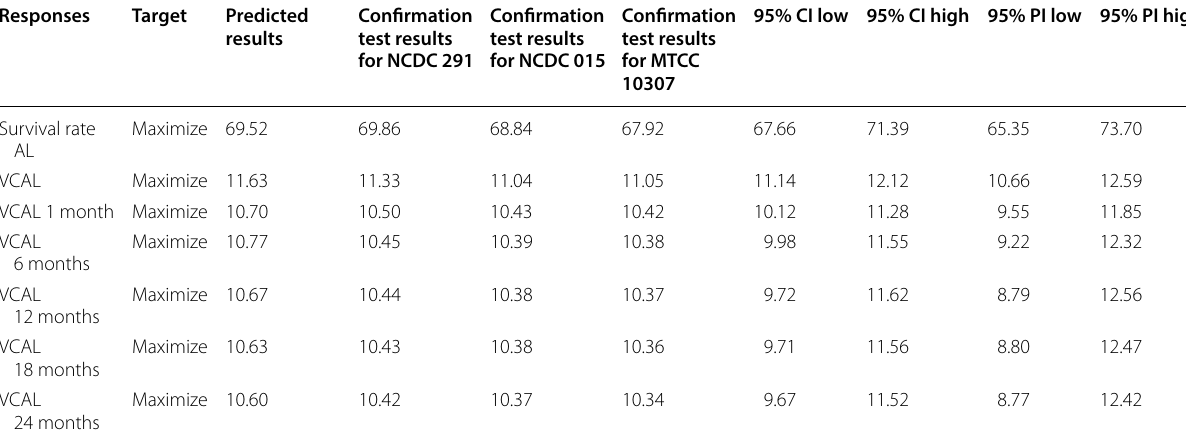
Table 5 Optimum process and validation experiment results at 95% confidence and prediction